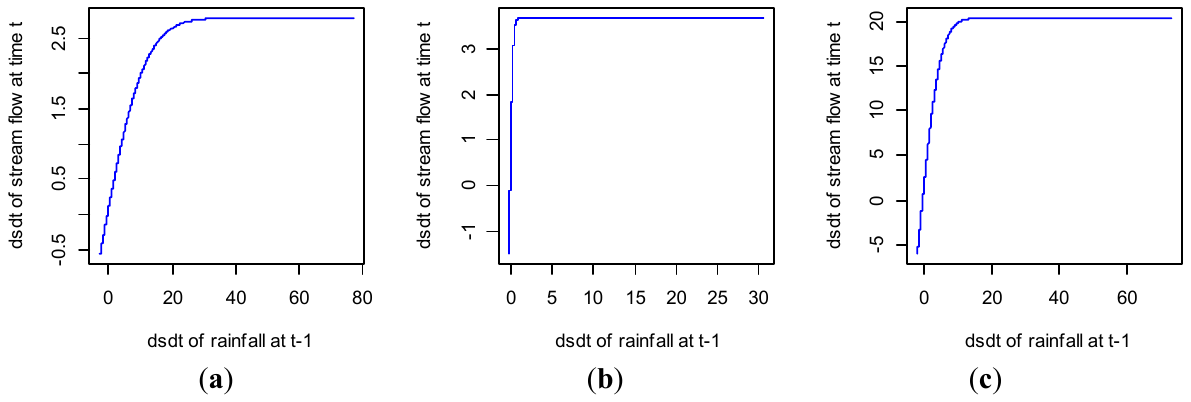
Figure 4. Predicted stream flow based on dsdt rainfall for ( a ) Broughton